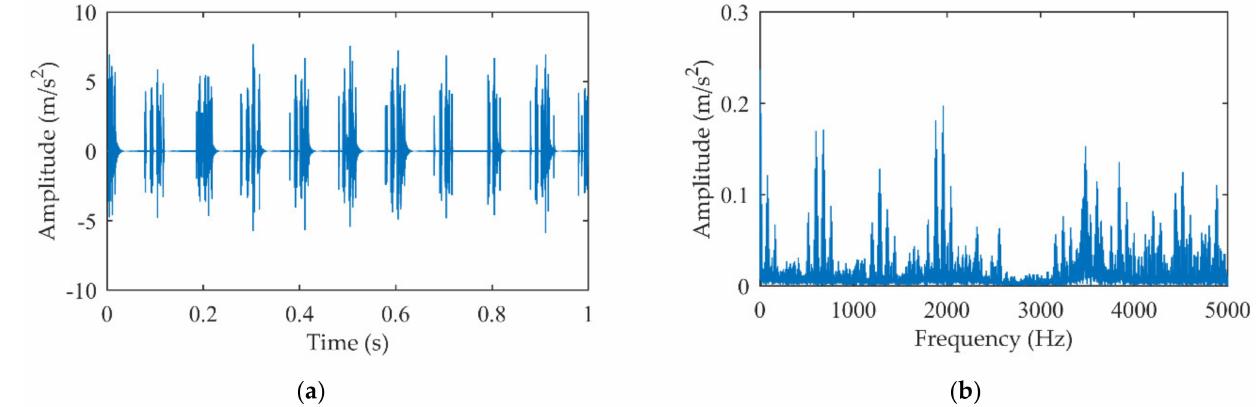
Figure 5. The extracted impact signal by traditional sparse decomposition: ( a ) Time domain signal; ( b ) Amplitude spectrum.